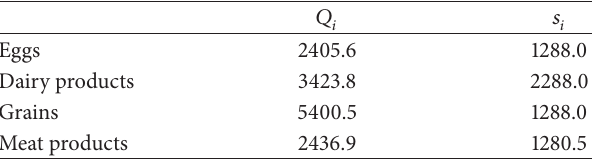
Table 3: Optimal order quantities and reorder